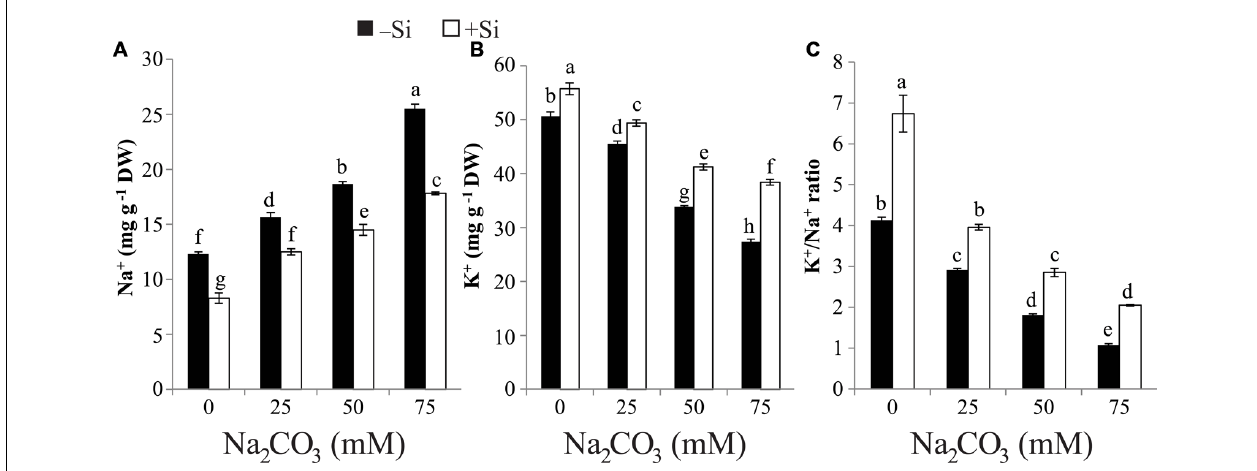
FIGURE 2 | Effects of different levels of alkaline stress with and without seed-priming with silicon (Si) on (A) Na + content, (B) K + content and (C) K + /Na + ratio in 25-day-old maize plants. Bars represent standard deviation (SD) of the means ( n = 3). Different letters indicate significant differences among the treatments at P < 0.05, according to Duncan’s multiple range test. DW, dry weight.